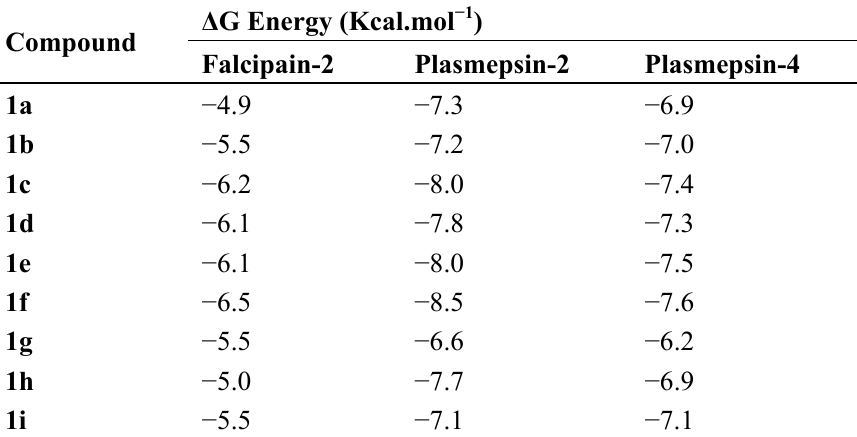
Table 3. Molecular docking of 4-metoxychalcone derivatives 1a – i to falcipain-2, plasmepsin-2 and plasmepsin-4.